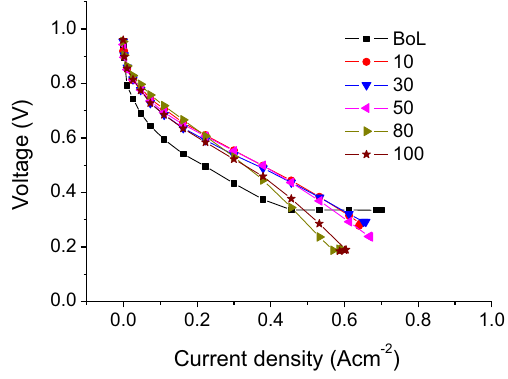
Fig. 4 The IV curves taken within the first 100 SU/SD cycles at ran- dom intervals. The IV curves were measured at 60 °C, 100% RH, atmospheric pressure and stoichiometric ratio of 1.8/2.5